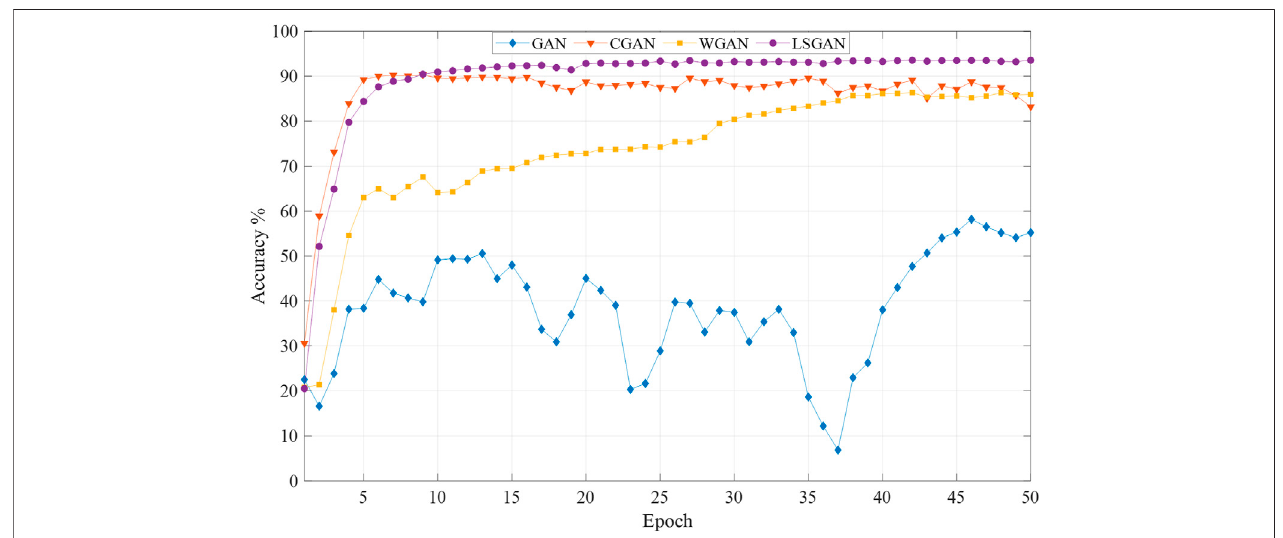
FIGURE 8 | Mean accuracy of reconstructed data by different methods during the training process.